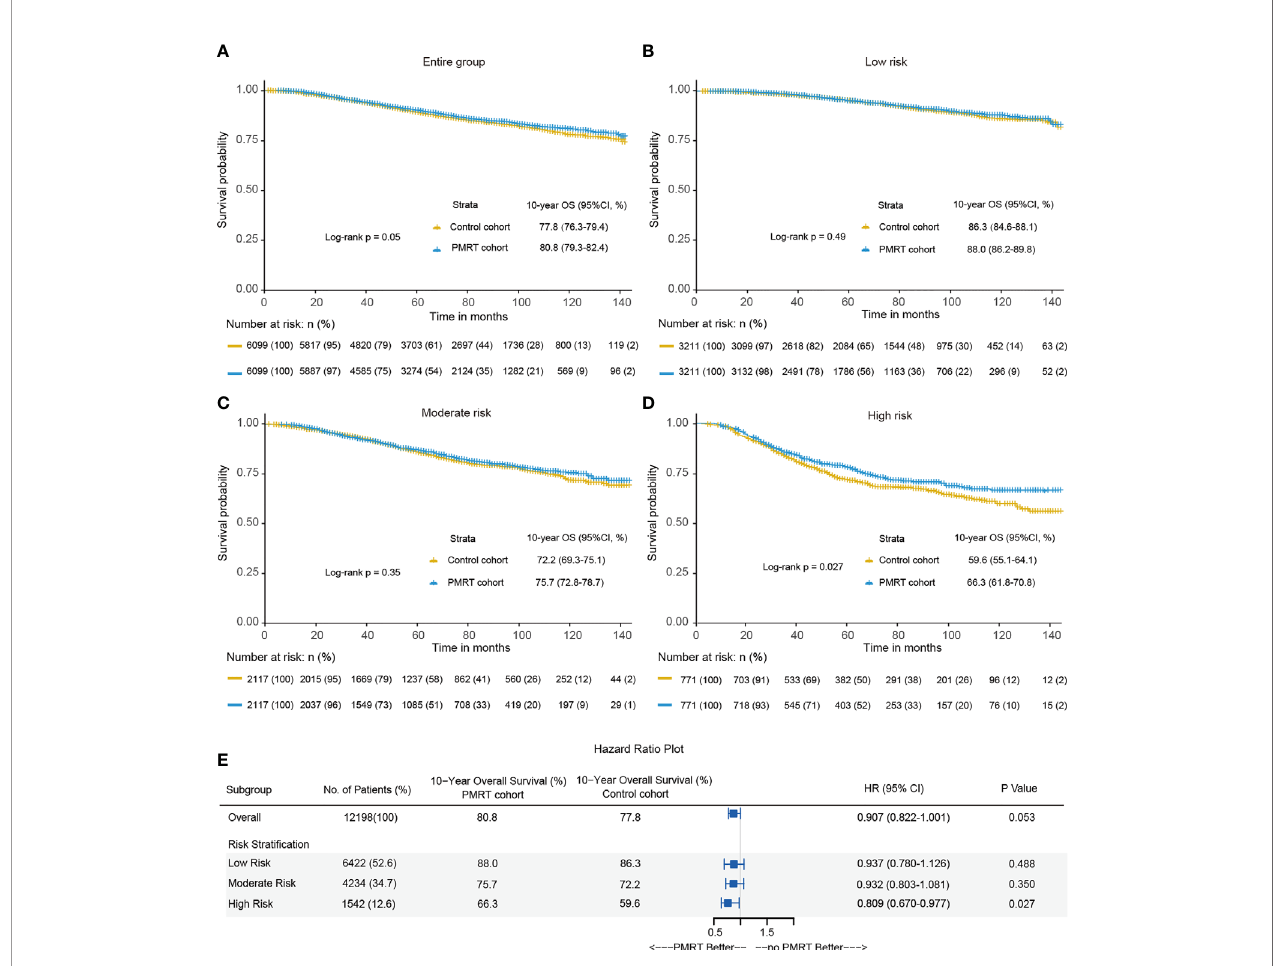
FIGURE 4 | Kaplan-Meier curves of overall survival between the PMRT cohort and observation cohort for the entire group (A) , low-risk group (B) , moderate-risk group (C) and high-risk group (D) after PSM. (E) The forest plot for hazard ratio (HR) comparing 10-year overall survival between the control cohort and PMRT cohort in different risk groups after